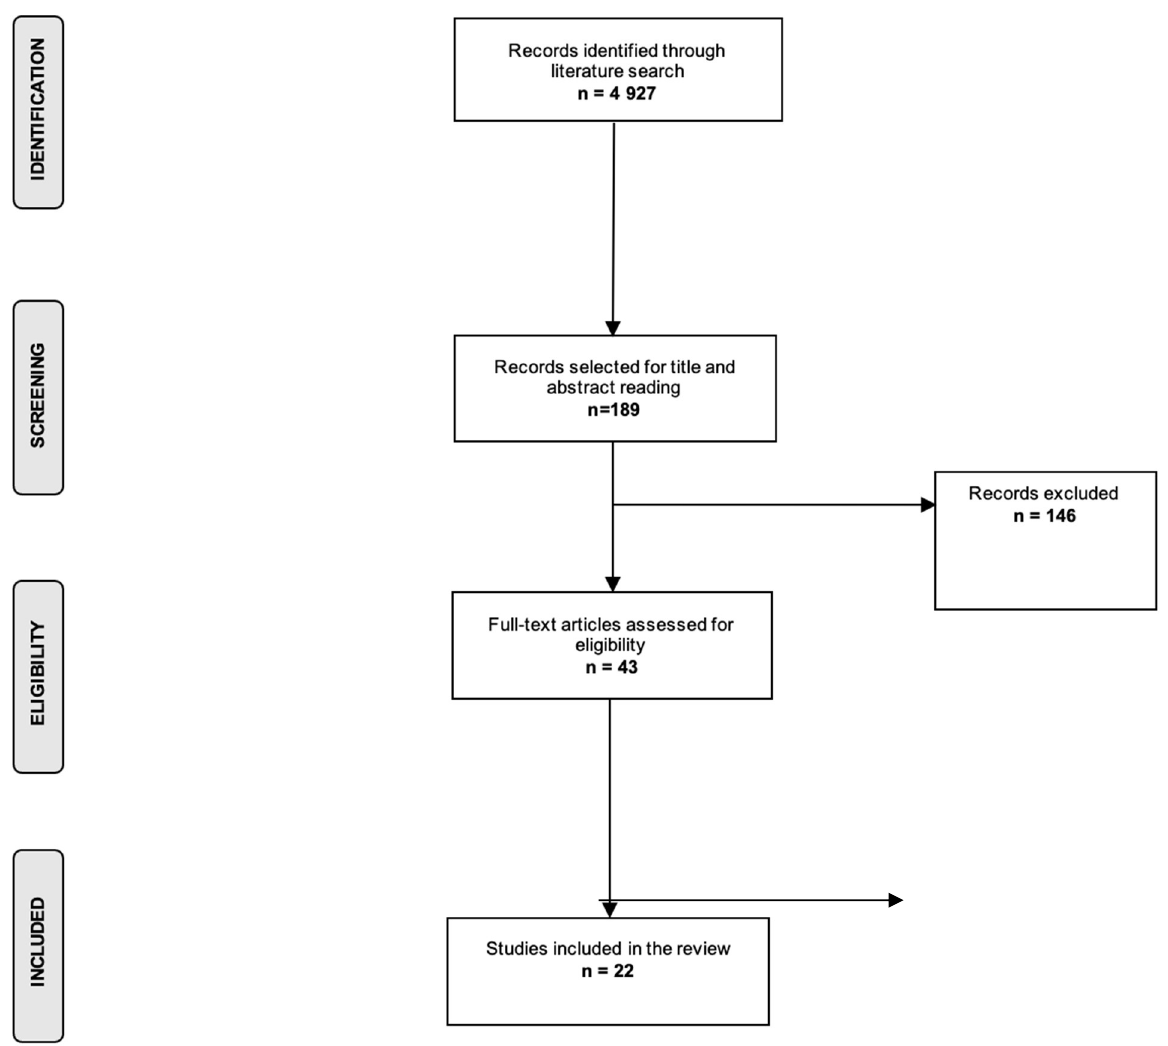
Figure 1. Flow chart of the selection